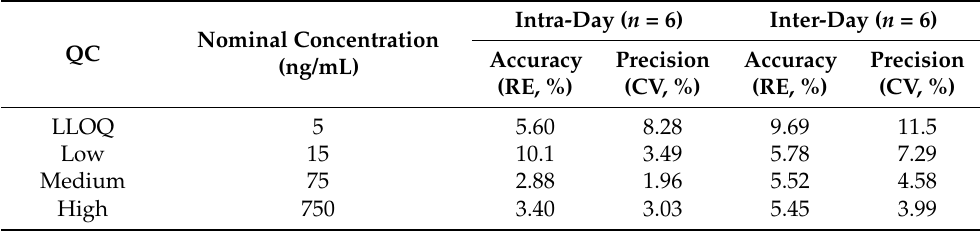
Table 4. Intra- and inter-day accuracy and precision of the UPLC-MS/MS method for the quantifica- tion of OJT007.